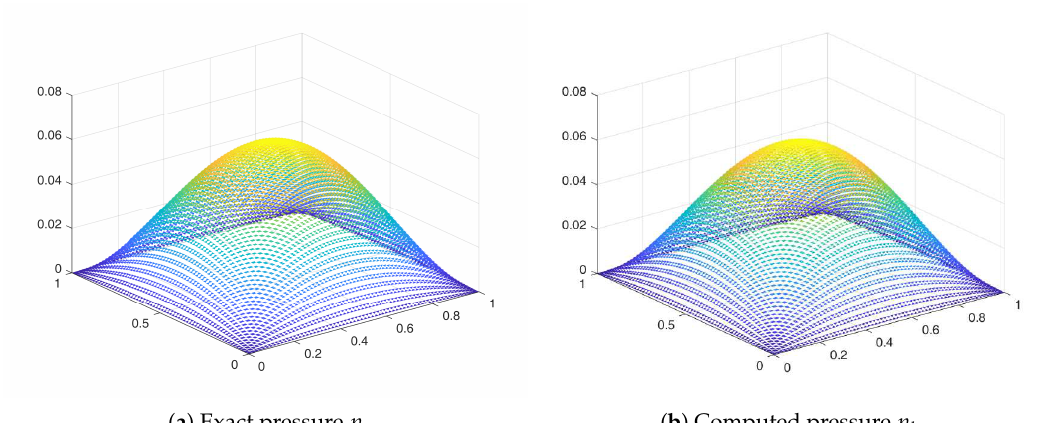
Figure 1. Exact and computed pressure for Example 1.